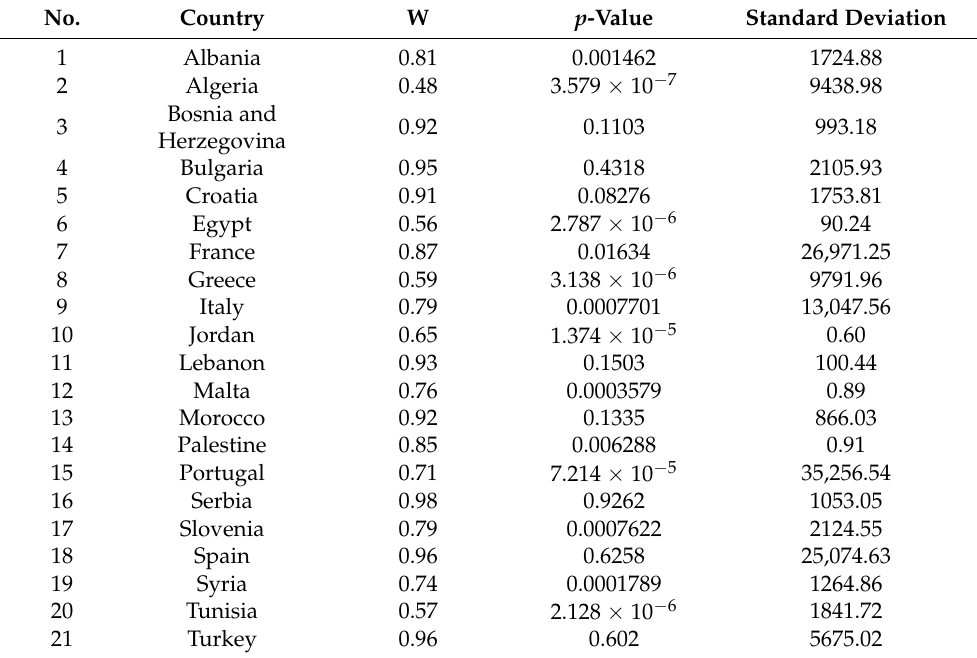
Table 3. Shapiro–Wilk normality test for data